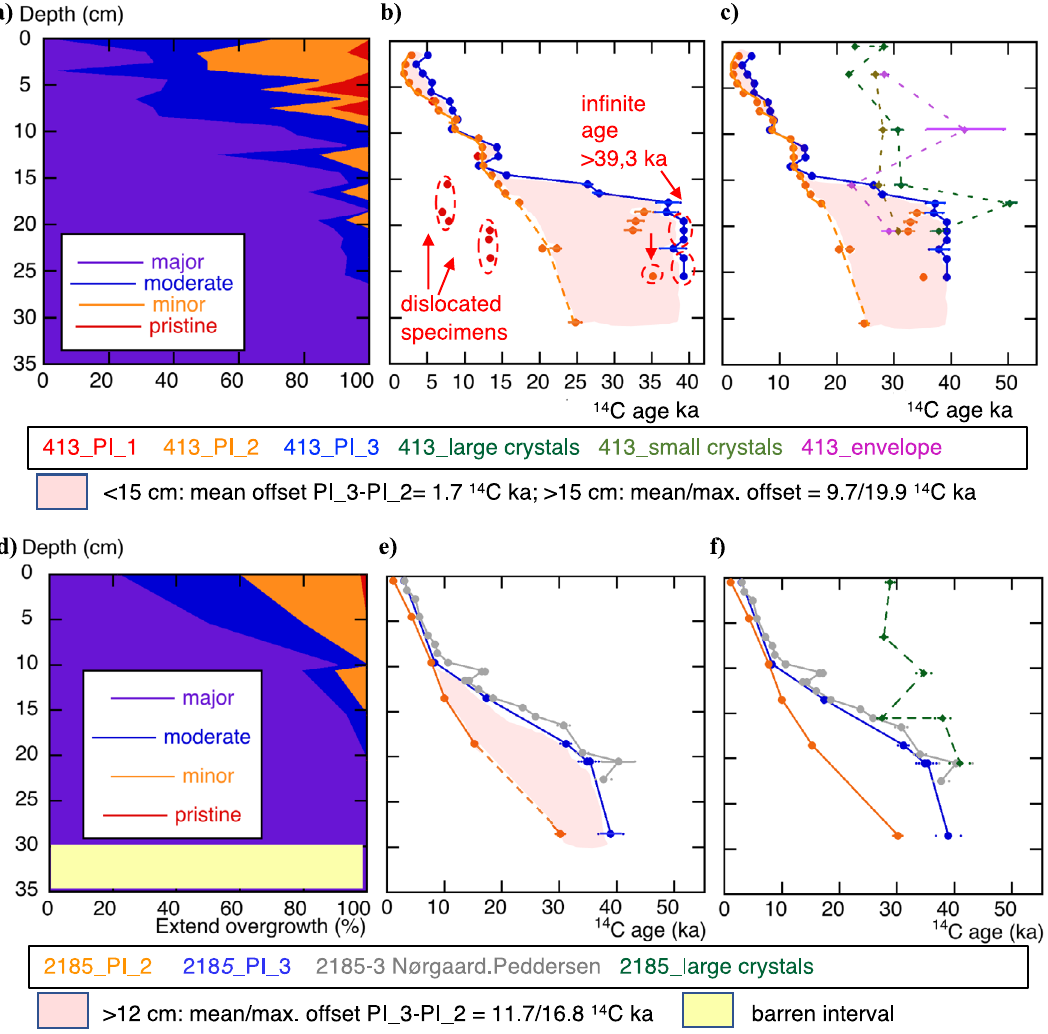
Fig. 6 Extent of overgrowth and radiocarbon ages of the respective preservation index categories. a – c PS72/413-3. a Mean relative estimates of overgrowth (no, minor, moderate, major). b , c 14 C age vs depth of PI_1-3 shells ( b ), and incl. crystals ( c ). d – f PS2185-6/3. d Mean relative estimates of overgrowth (no, minor, moderate, major). e , f 14 C age vs depth of PI_1-3 shells ( e ), and incl. crystals ( f ). Please note that PI-measurements ( b , c and e , f ) are based on stereomicroscope investigations, mean relative estimates ( a and d ) additionally on SEM analysis. However, major overgrowth was usually noticed on discolored brownish specimens, that were not measured, thus are not included in PI_3 results. Error bars represent ±2 σ analytical